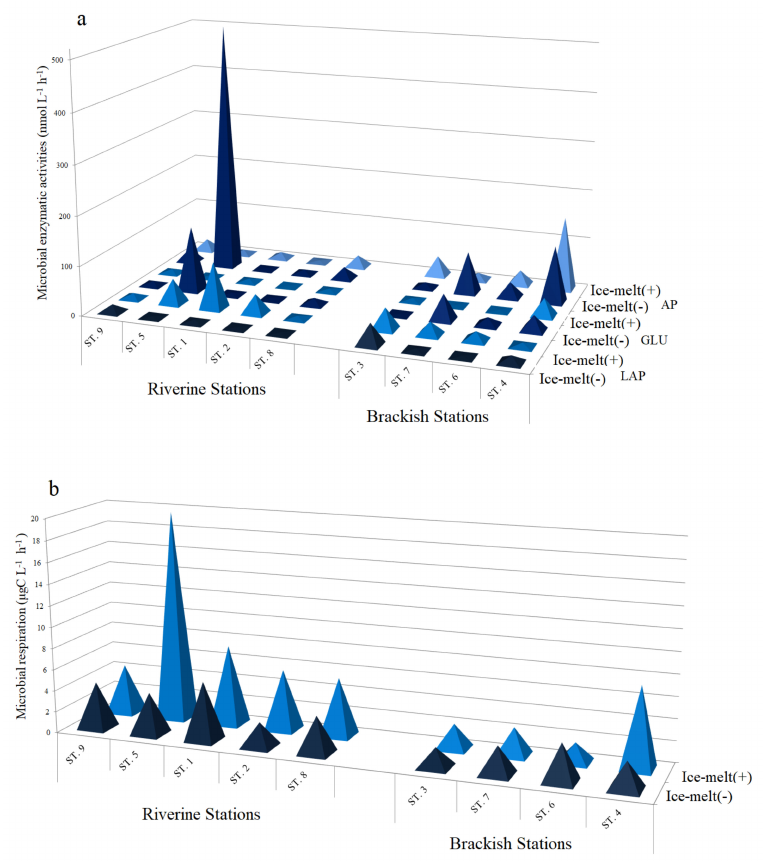
Figure 3. Microbial activities in water samples from the Pasvik River. ( a ) Enzymatic activities; ( b ) respiratory